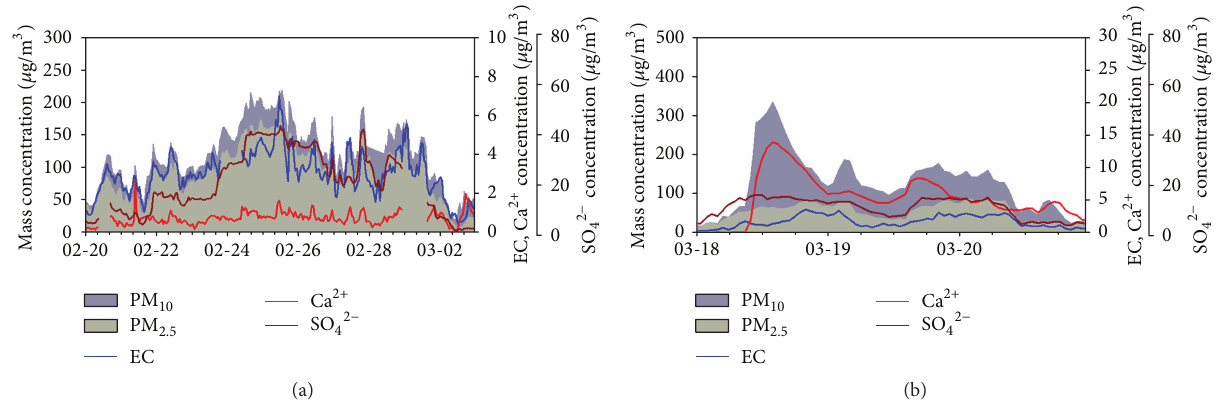
Figure 5: Time series of ionic calcium, elemental carbon, and sulfate concentration in (a) Case 1 and (b) Case 2